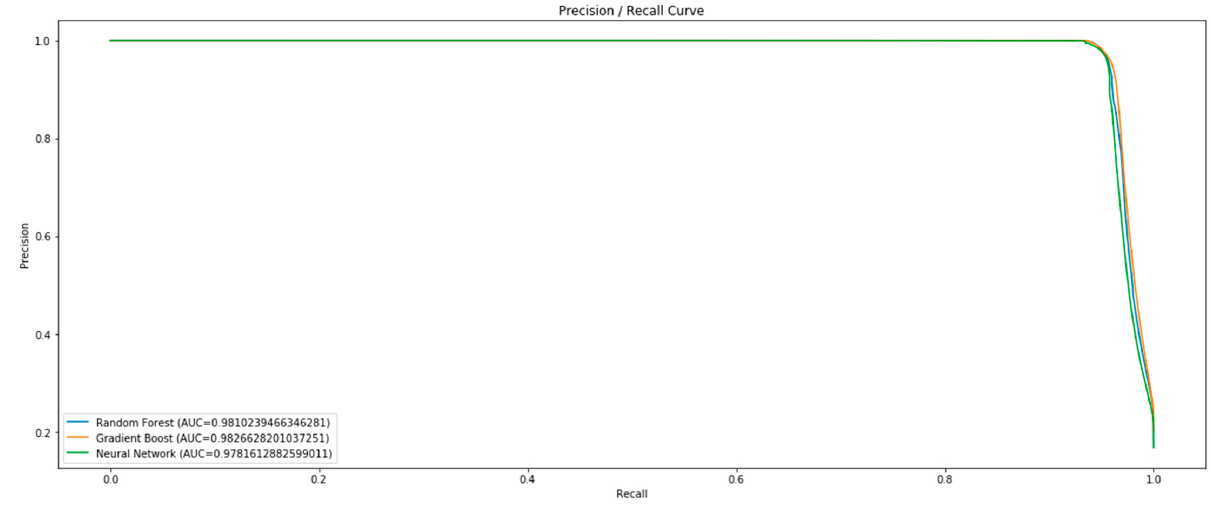
Figure 17. Precision/Recall curves of the different models.